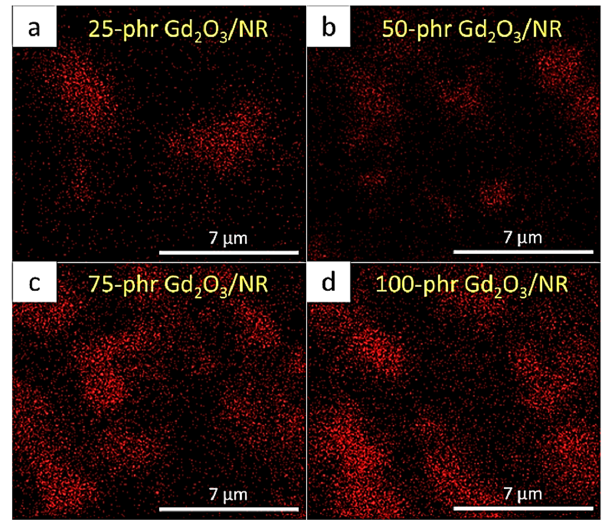
Figure 5. Dispersion of Gd 2 O 3 /NR composites containing varying Gd 2 O 3 contents captured using SEM-EDX: ( a ) 25 phr, ( b ) 50 phr, ( c ) 75 phr, and ( d ) 100 phr.